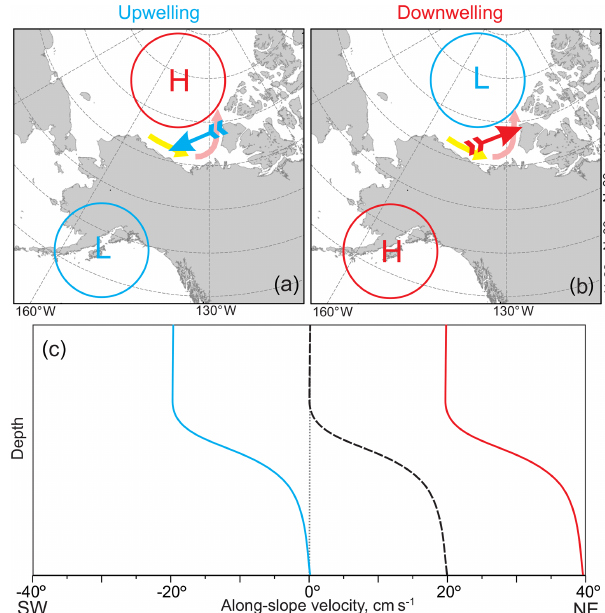
Figure 11. Schematic depiction showing atmospheric forcing for (a) upwelling and (b) downwelling along the eastern Beaufort Sea continental slope adopted from Kirillov et al. (2016). Blue and red arrows indicate geostrophic wind associated with concurrence be- tween the atmospheric low and high depicted by blue and red cir- cles, respectively. Yellow and pink arrows show circulation with shelf-break jet over the western and eastern Beaufort Sea, respec- tively, intensified by local downwelling. (c) Schematic depiction suggesting the generation of surface-intensified (blue curve) and depth-intensified (red curve) along-slope currents as a result of up- welling and downwelling, respectively, superimposed on the hypo- thetical bottom-intensified shelf-break current (black dashed curve) following Dmitrenko et al.